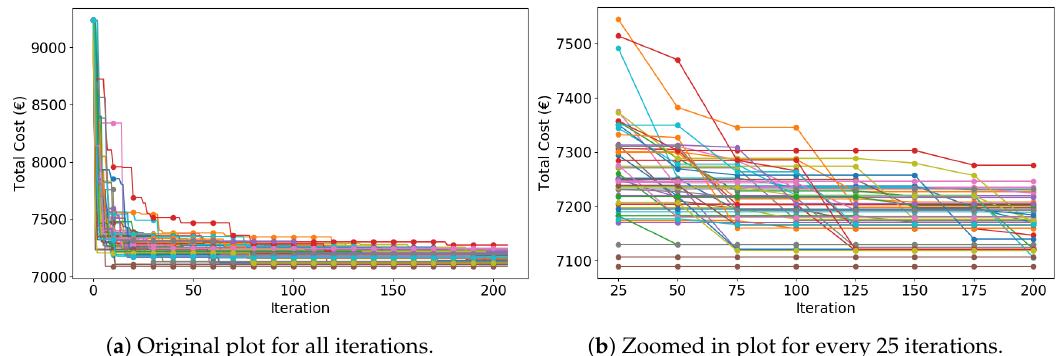
Figure 9. Total cost as a function of random choice algorithm (RCA) iterations (50 curves of 50